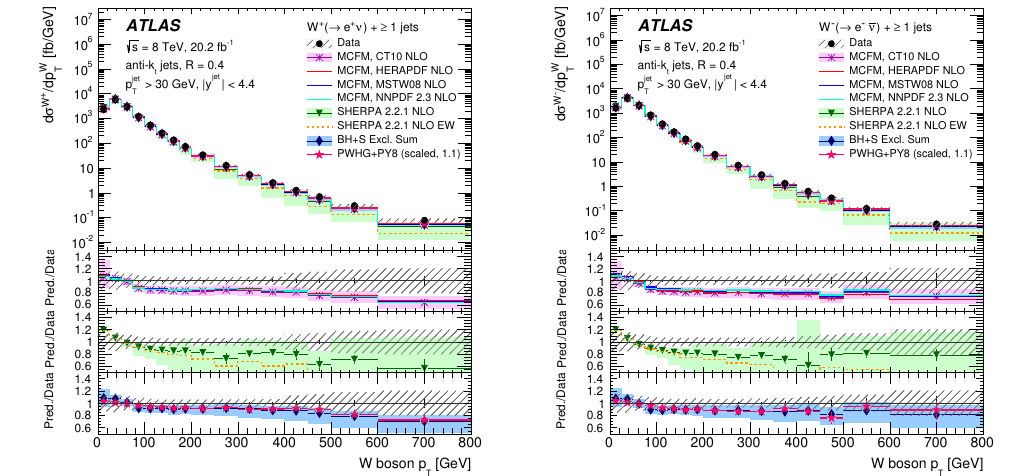
Figure 22 . Di(cid:11)erential cross sections for the production of W + (left) and W (cid:0) (right) as a function of the W p T for events with N jets (cid:21) 1. For the data, the statistical uncertainties are indicated as vertical bars, and the combined statistical and systematic uncertainties are shown by the hatched bands. The uppermost panel in each plot shows the di(cid:11)erential cross sections, while the lower panels show the ratios of the predictions to the data. The theoretical uncertainties on the predictions are described in the text. The arrows on the lower panels indicate points that are outside the displayed range.